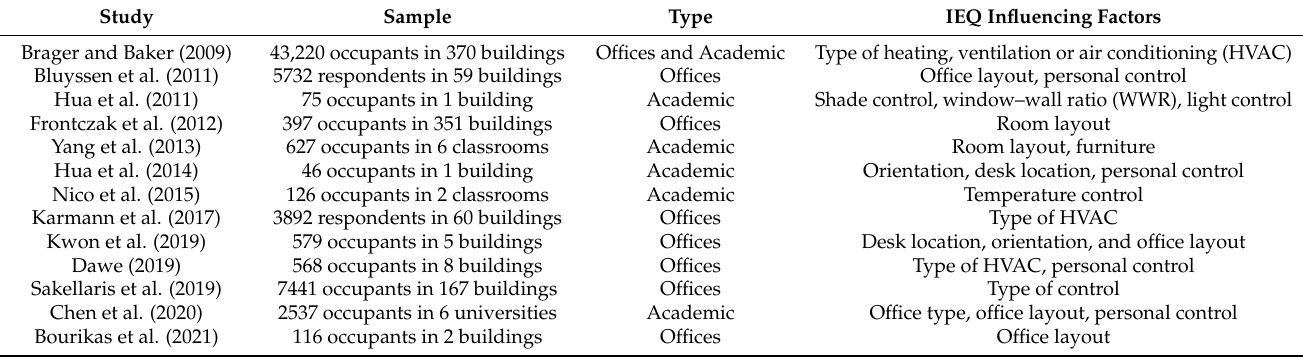
Table 1. Summary of studies on the association between building characteristics and indoor environmental quality (IEQ) through post occupancy evaluations